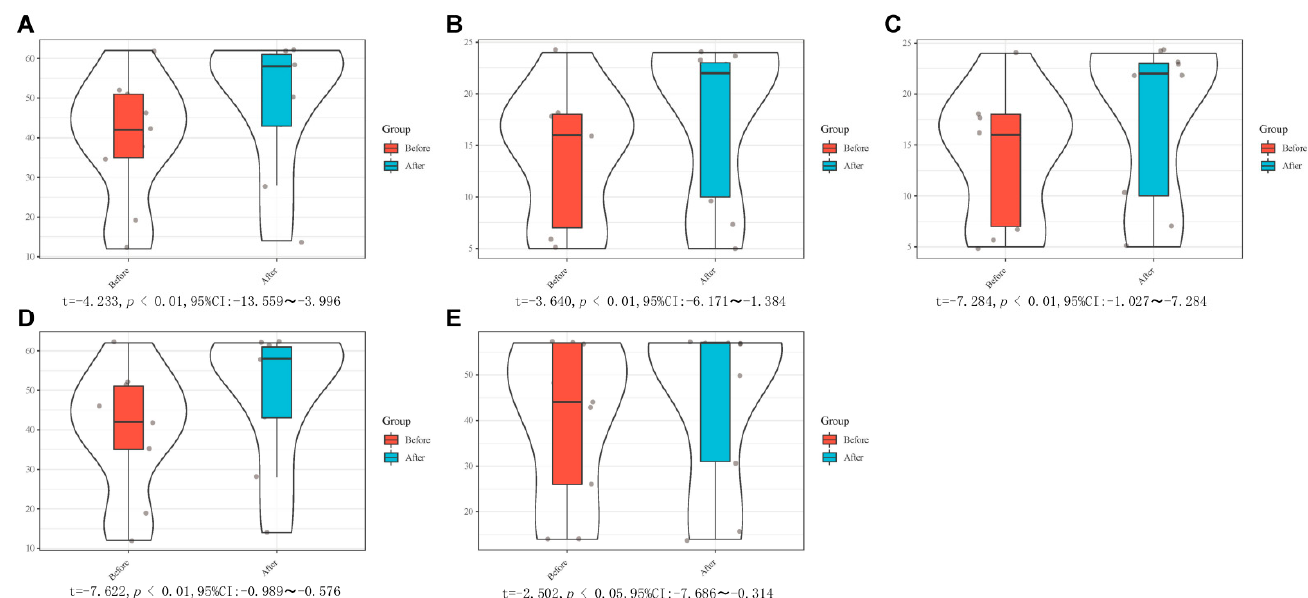
Figure 8. Comparison of differences of FMA-UE, FMA-W/H, Brunnstrom and ARAT before and after treatment. ( A ) FMA-UE; ( B ) FMA-W/H; ( C ) Brunnstrom (hand); ( D ) Brunnstrom (upper limb); ( E ) ARAT.